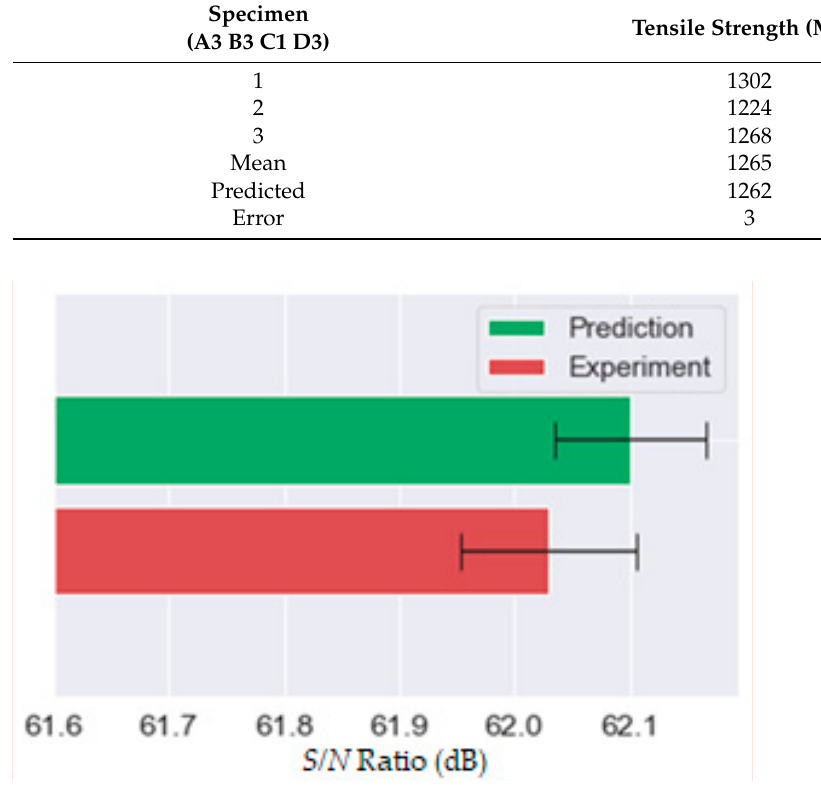
Figure 6. Predicted and experimental values of the optimal tensile strength.